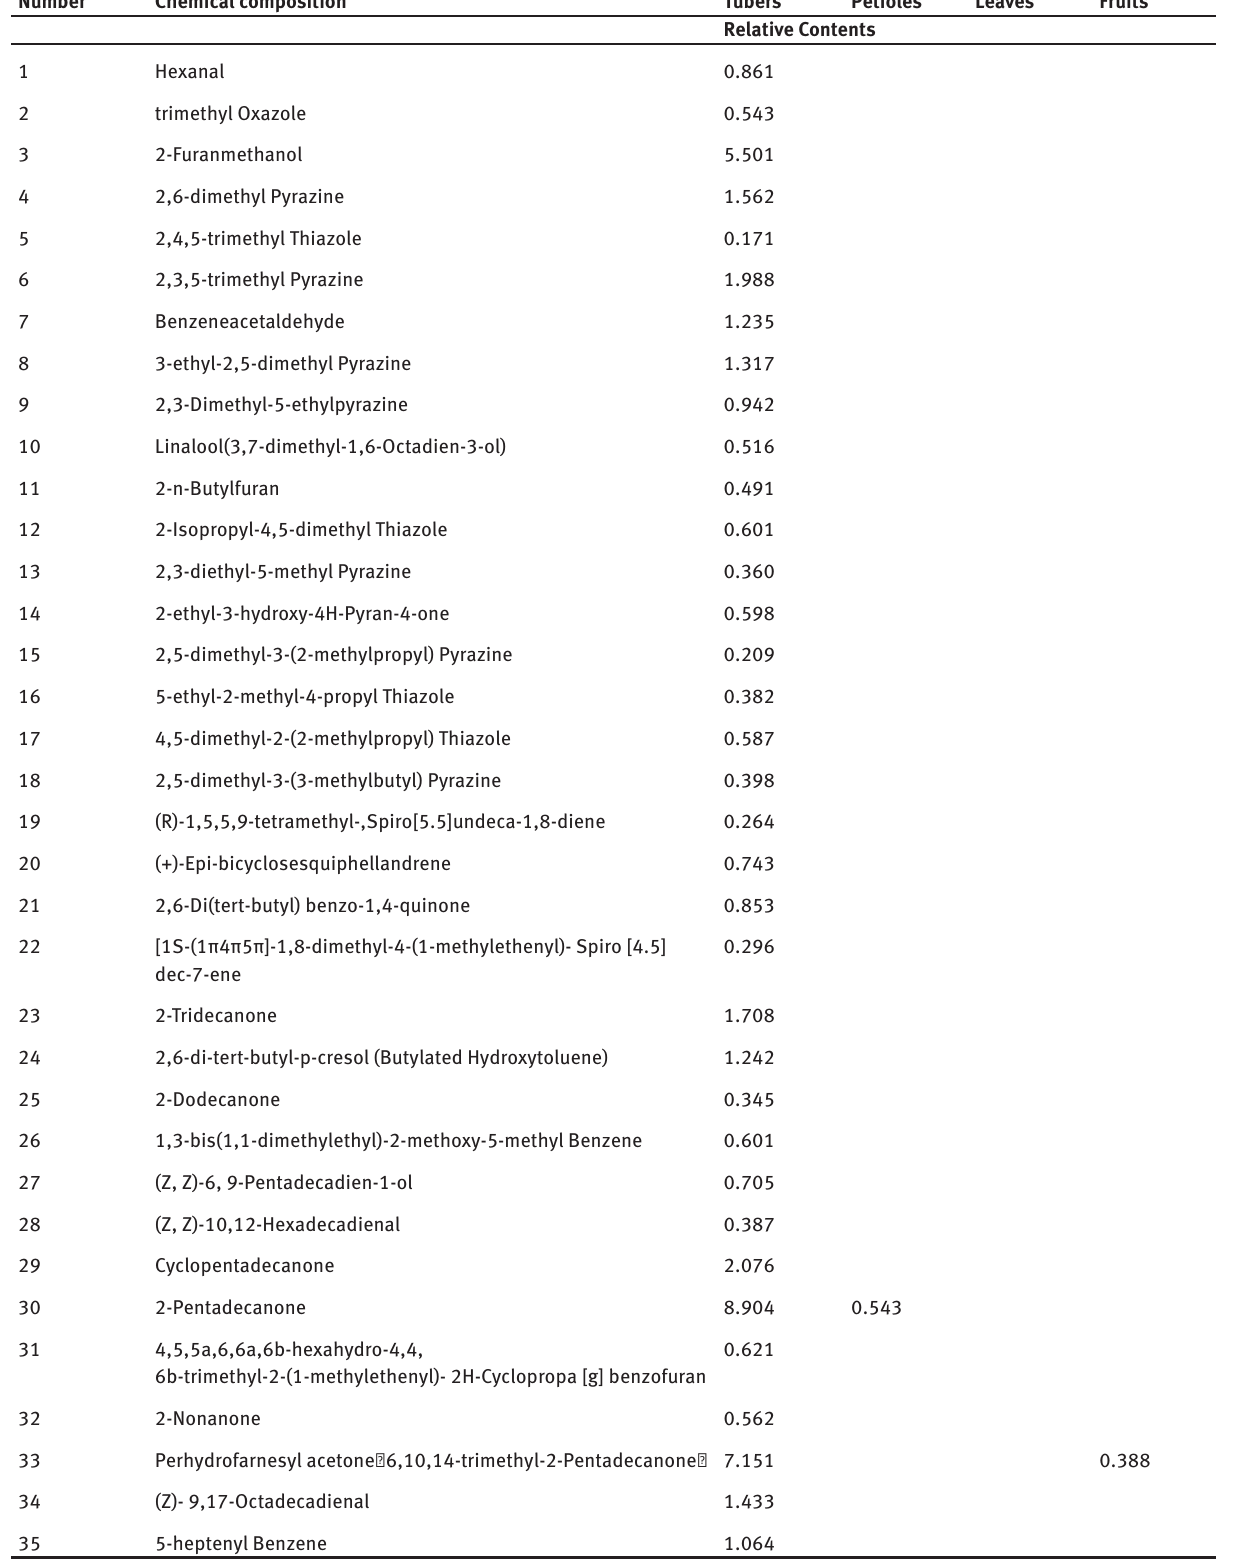
Table 1: Analysis on chemical constituent of essential oil in every parts of Arisaema Amurense Maxim by GC-MS.